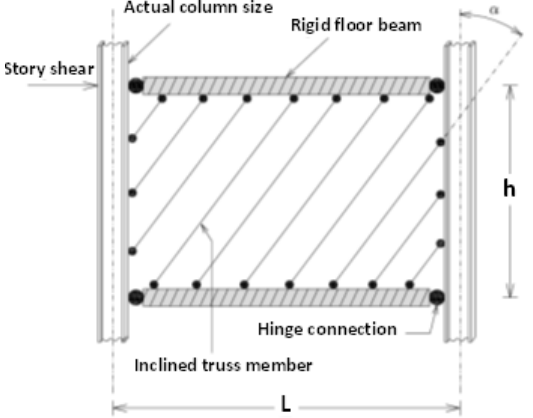
Fig. 1. Modified Strip Model (Driver et al.,